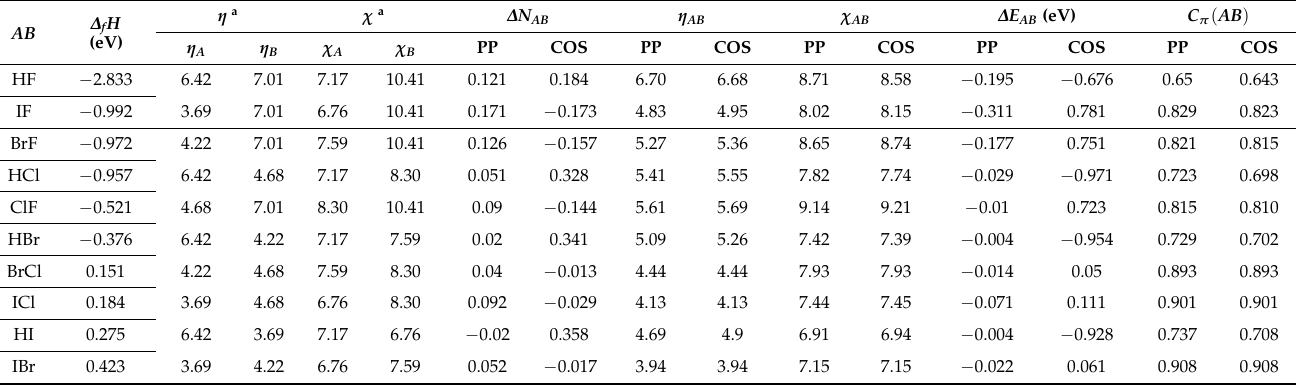
Table 2. The numerical comparison between sensitivity indices (charge transfer, average hardness, average electronegativity, exchanged energy and the introduced chemical power) for Parr–Pearson (in table: PP) and present (in table: COS) approaches for selected diatomic molecules, respectively. ∆ f H is the gas phase standard enthalpy of formation at 298.15 K [75]. All energetic values are in eV (electron-volts)